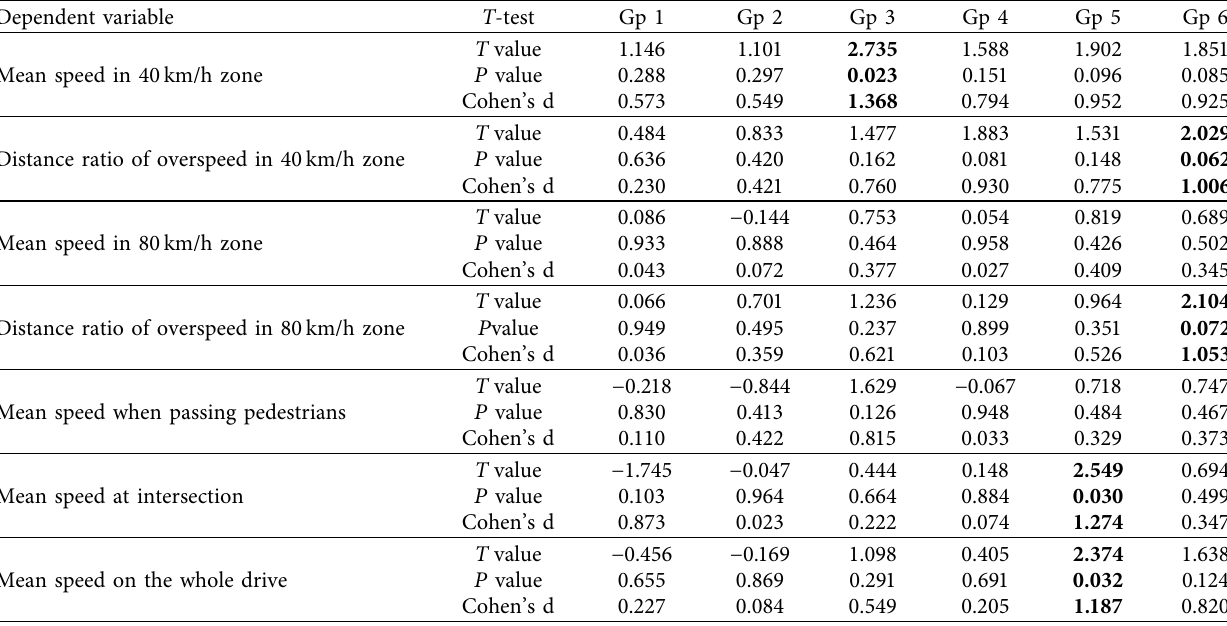
Table 4: Summary of the T -test results.